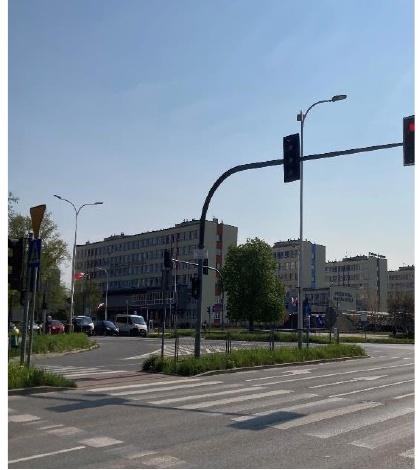
Figure 10. Observation site: pedestrian crossing number 2.